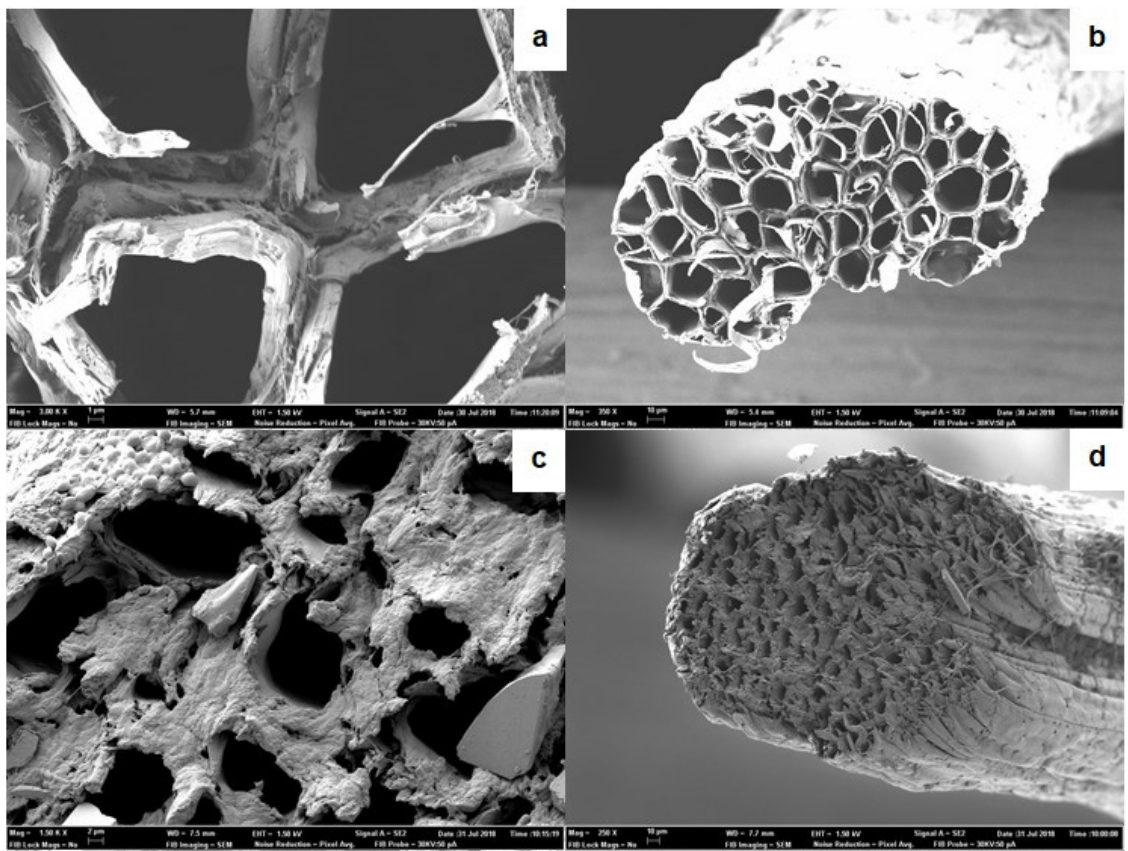
Figure 6. FSEM images of fique fiber showing the binding between monofilaments: ( a ) without enzymatic modification, ( b ) after enzymatic treatment with pectinase, and after biosorption of dye (previously modified with pectinase) ( c , d ).